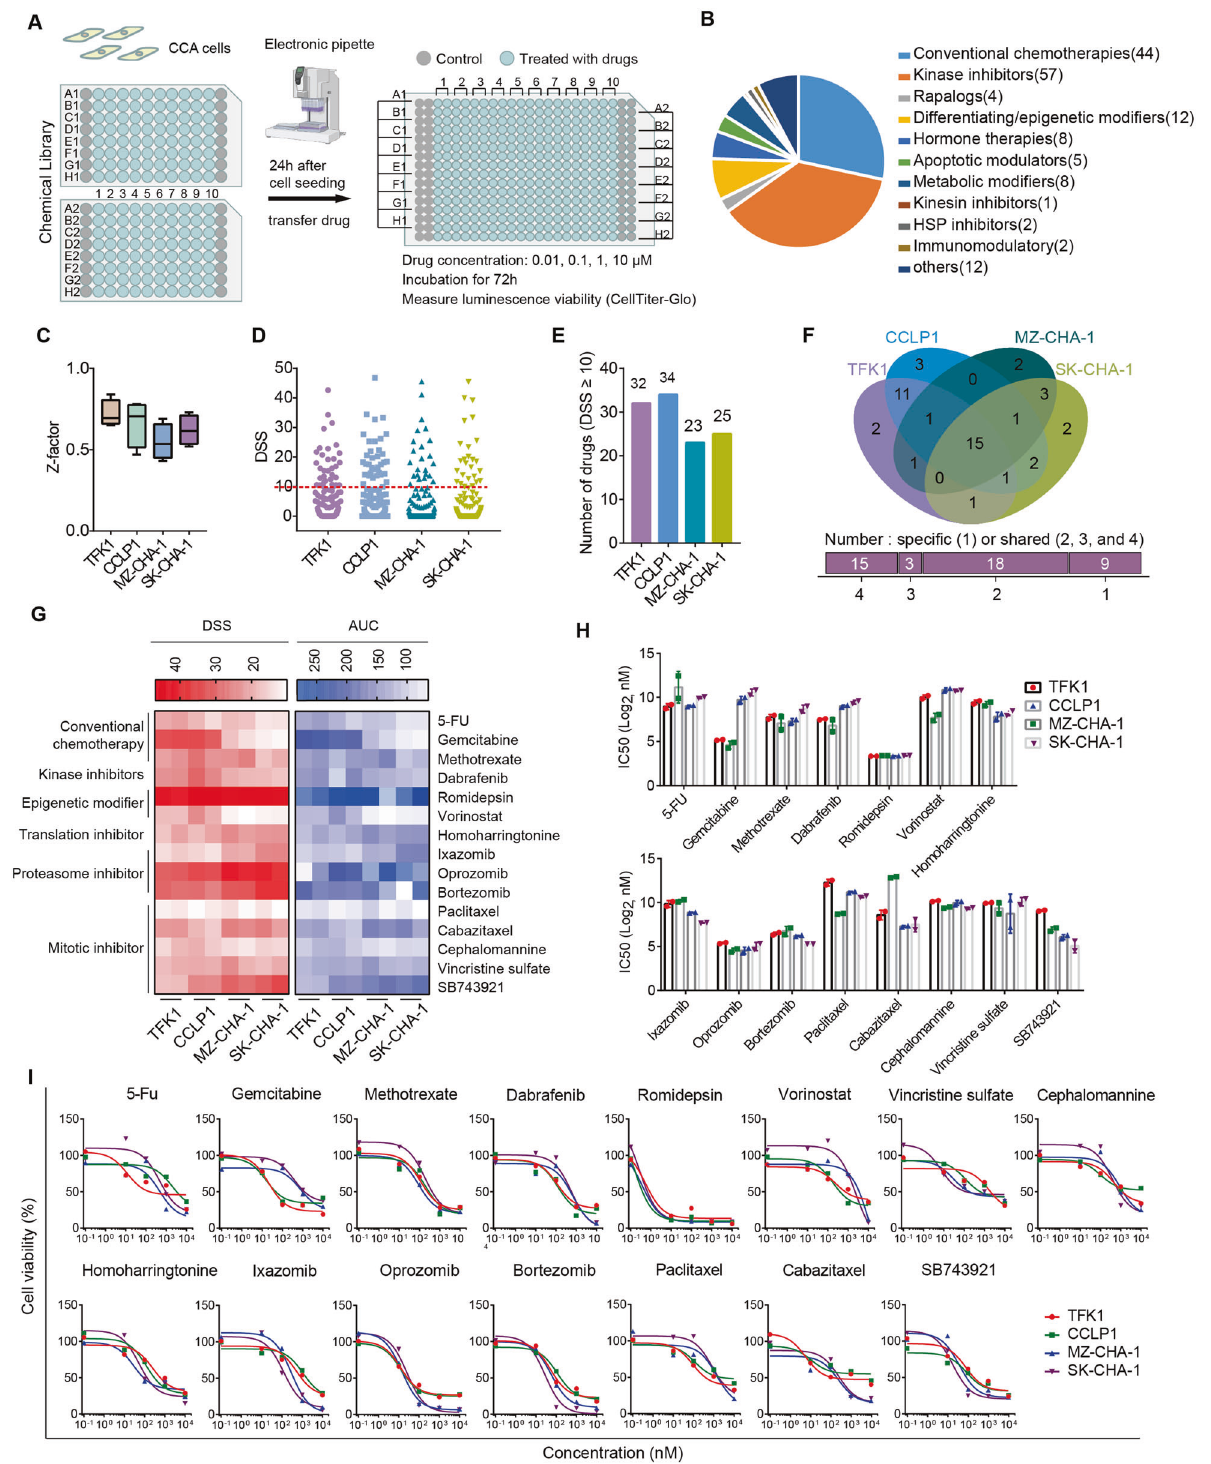
Fig. 1 A high-throughput drug screen to identify drugs targeting CCA. A Design of the high-throughput drug screen. Four CCA cell lines (TFK1, CCLP1, SK-CHA-1, MZ-CHA-1) were seeded into 384-well plates and treated with drugs in the chemical library for 72 h. Experiments were performed at four concentrations per drug (10, 1, 0.1, 0.01 μ M) and two replicates were set for each treatment. B Categories of compounds in the chemical library used for the screen. The number of each drug was shown in the fan chart. C The Z-factors of cell viability for each plate of CCA cell lines. The ends of the box are the upper and lower quartiles, vertical lines inside the box show the median, and whiskers mark the minimum and maximum Z-factors for each plate of CCA cell lines. D The DSS (drug sensitivity score) for each drug in the four CCA cell lines. E The number of drugs with a DSS ≥ 10 in four CCA cell lines. F Venn diagram of identi fi ed drugs with DSS ≥ 10 in four CCA cell lines. 15 drugs were identi fi ed with DSS ≥ 10 in all four cell lines. G The DSS and AUC (area under the drug-response curve) of drugs with DSS ≥ 10 in all four cell lines. H IC 50 values of the 15 drugs in four cell lines. I Dose-response curves for the effect of 15 sensitive drugs on cell viability.